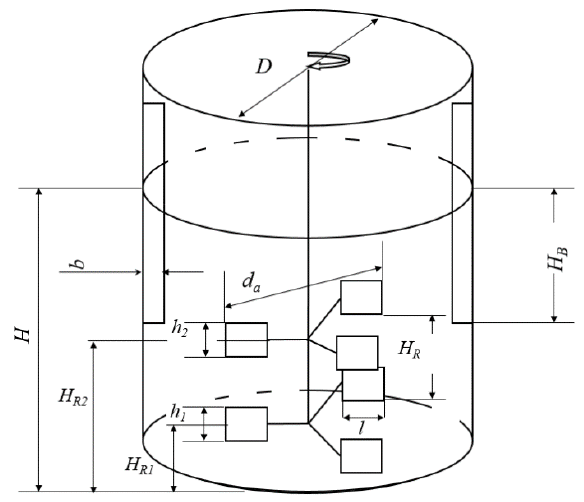
Figure 2. Scheme of apparatus with a two-row six-blade turbine mixer.